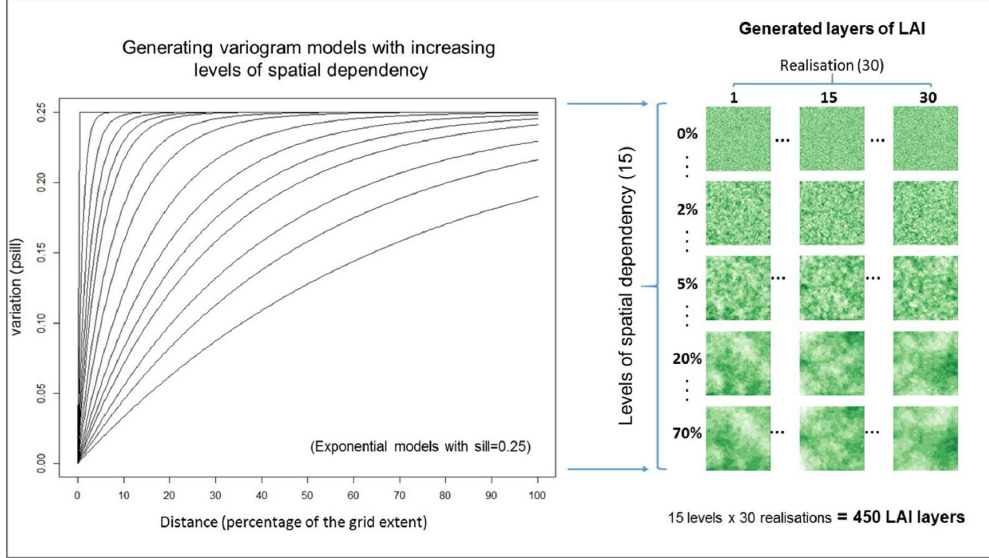
Figure 1. Generation of Leaf Area Index (LAI) layers at 15 levels of spatial dependency.